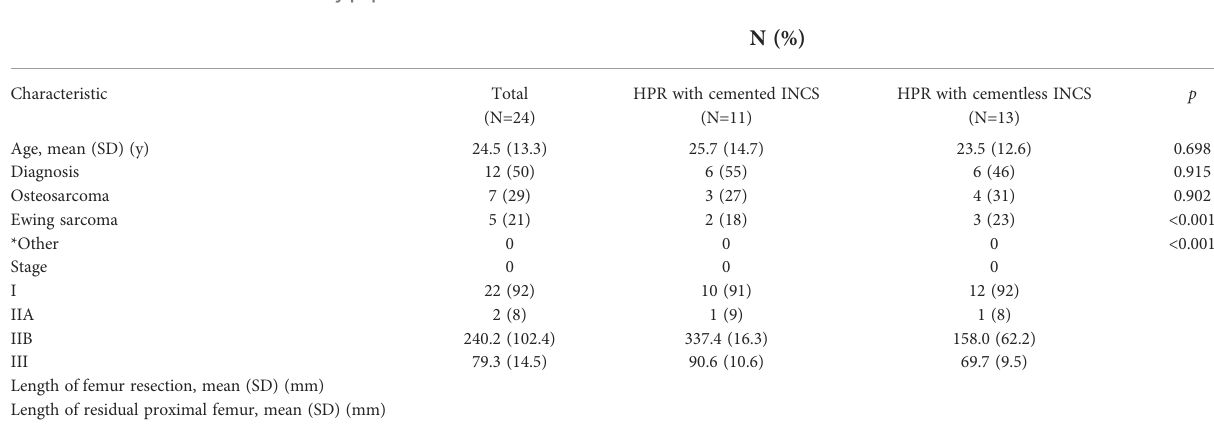
TABLE 1 Patient characteristics of study